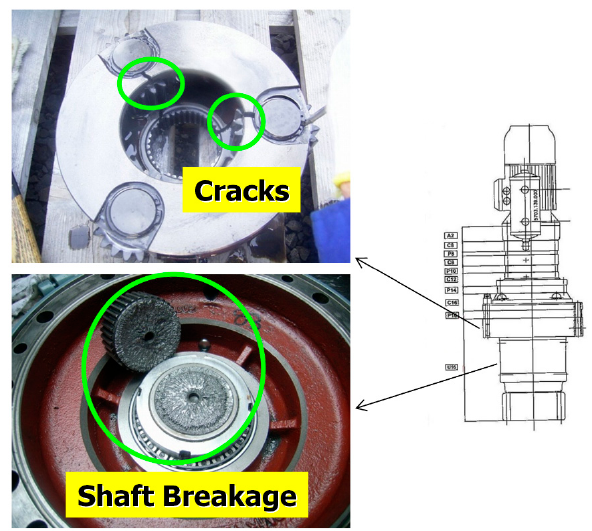
Figure 3. Yaw gear damage at wind turbine #7 (T7).